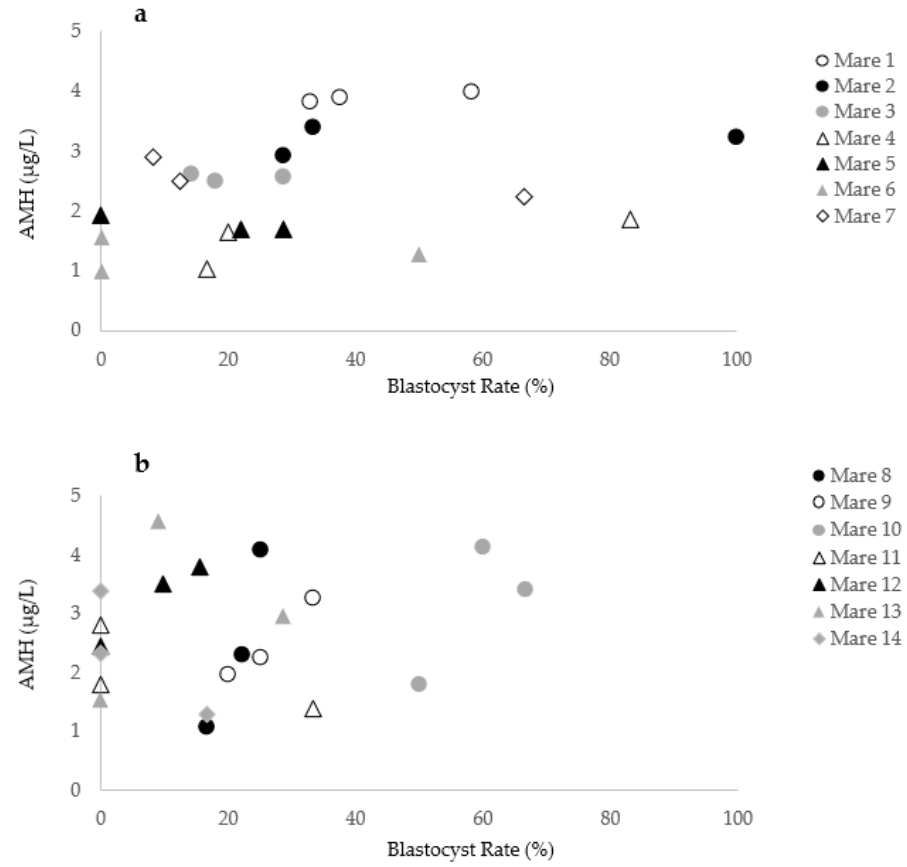
Figure 6. Variation in the blastocyst rate and AMH concentration in 14 individual mares during three OPU-ICSI cycles. ( a ) Mares 1 to 7 with similar AMH levels over different cycles.; ( b ) Mares 8 to 14 with a high variability in AMH levels over the consecutive cycles.